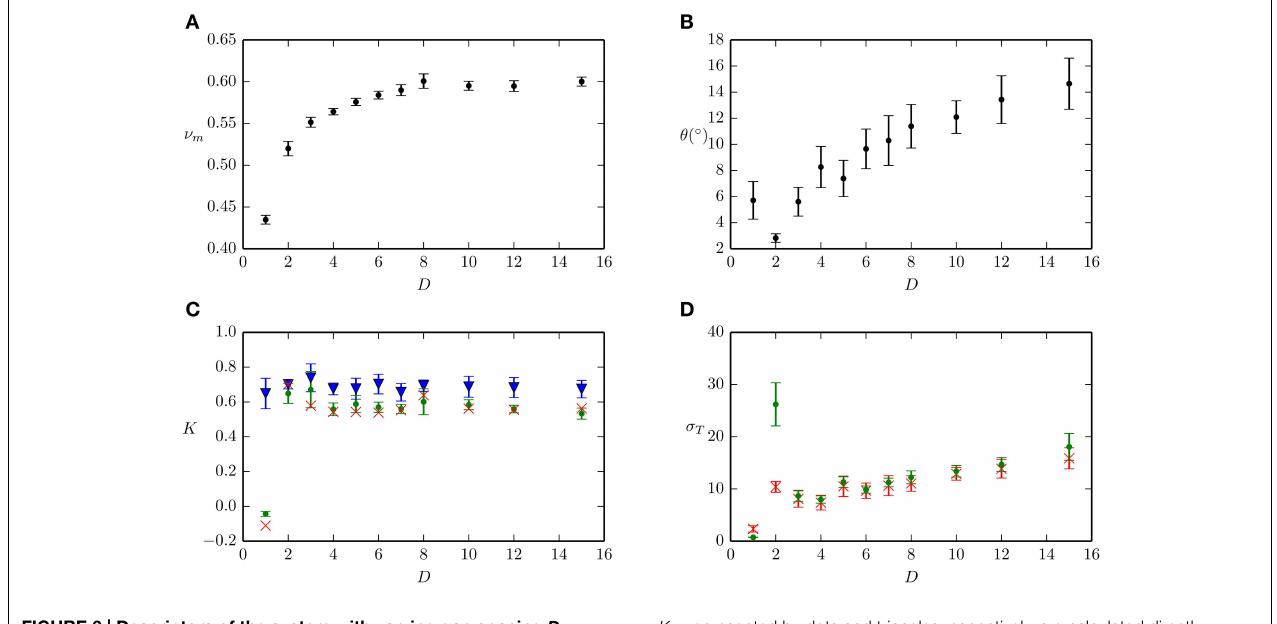
K y , represented by dots and triangles respectively, are calculated directly from the coarse grained granular packing. (D) Threshold stress σ T . Dots represent the mean value of the coarse grained continuum field σ xx at x = L , and crosses represent predicted values from Equation (5) using measured values of ν m , θ and φ 0 .